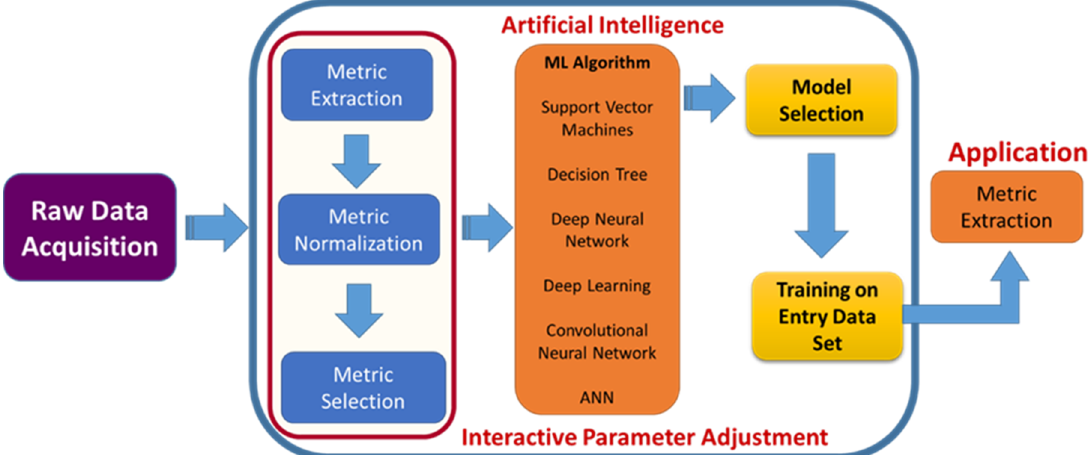
Figure 9. Role of AI in surgery. Framework integrating AI in spinal surgeries, which involves raw data acquisition to convert the inputs into digitalized form and pre-processing methods for machine learning such as metric extraction to train the ML and metric selection to differentiate between two groups. The optimum algorithm is selected based on the input, and then the output is generated .